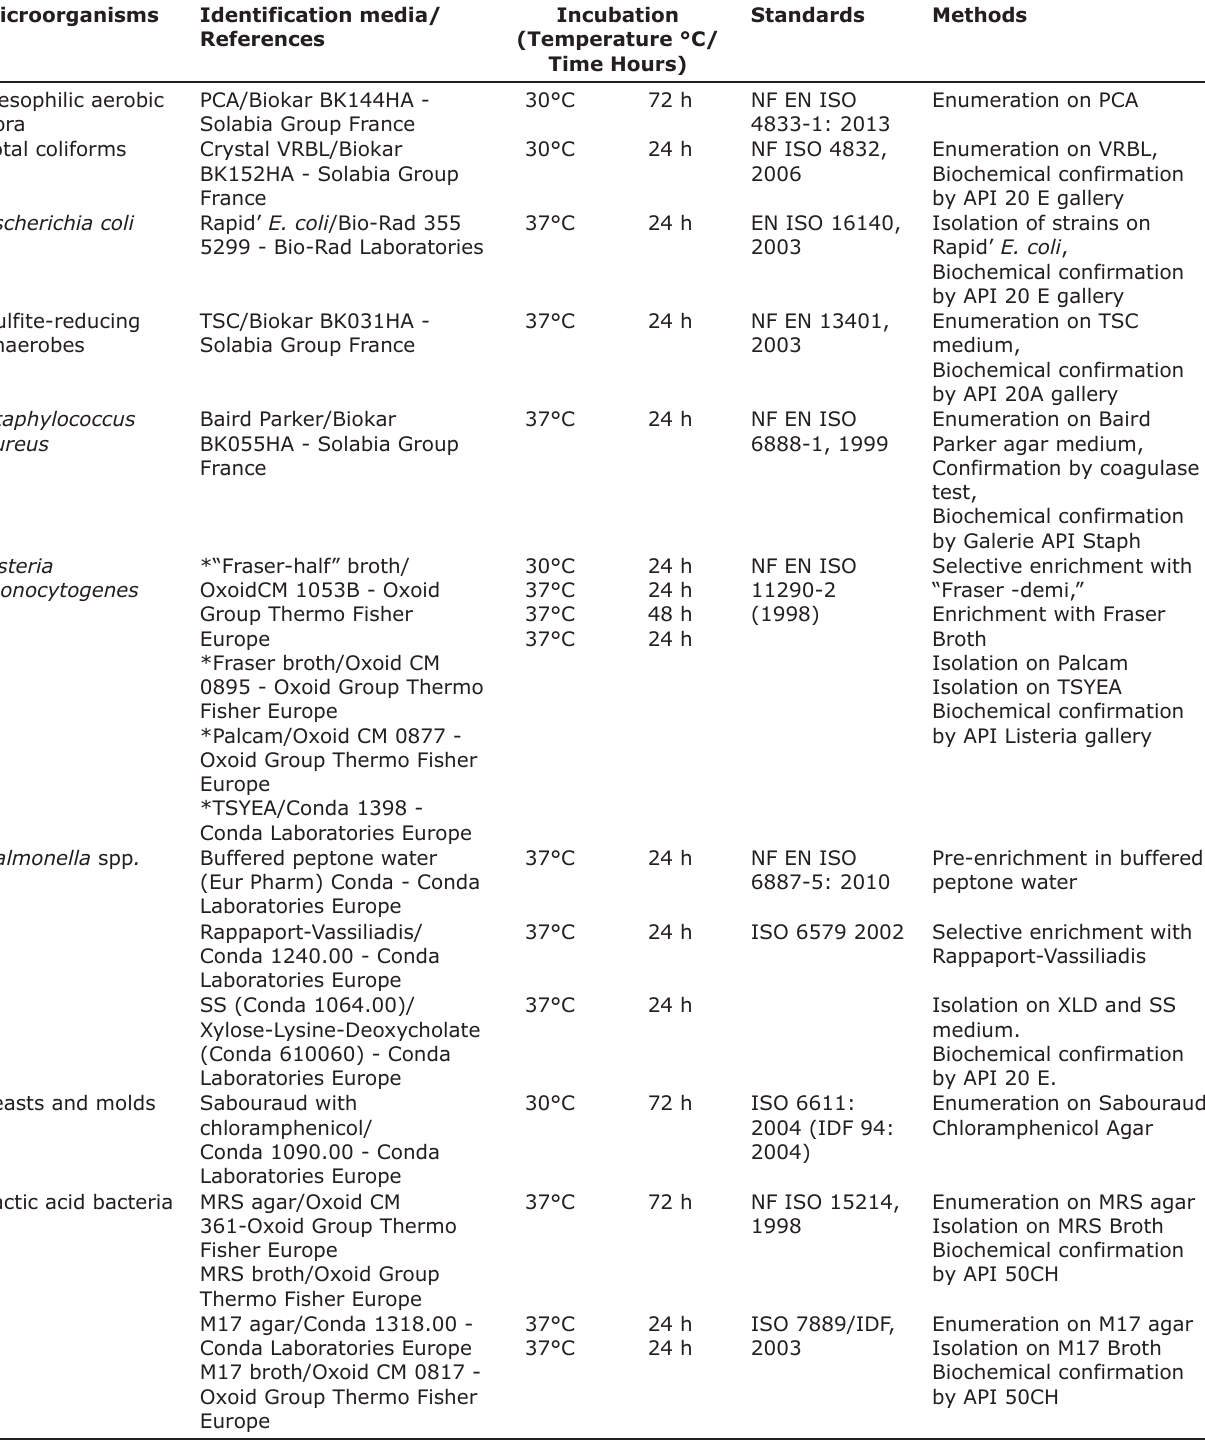
Table-2: Culture media used for the isolation of microorganisms in milk.